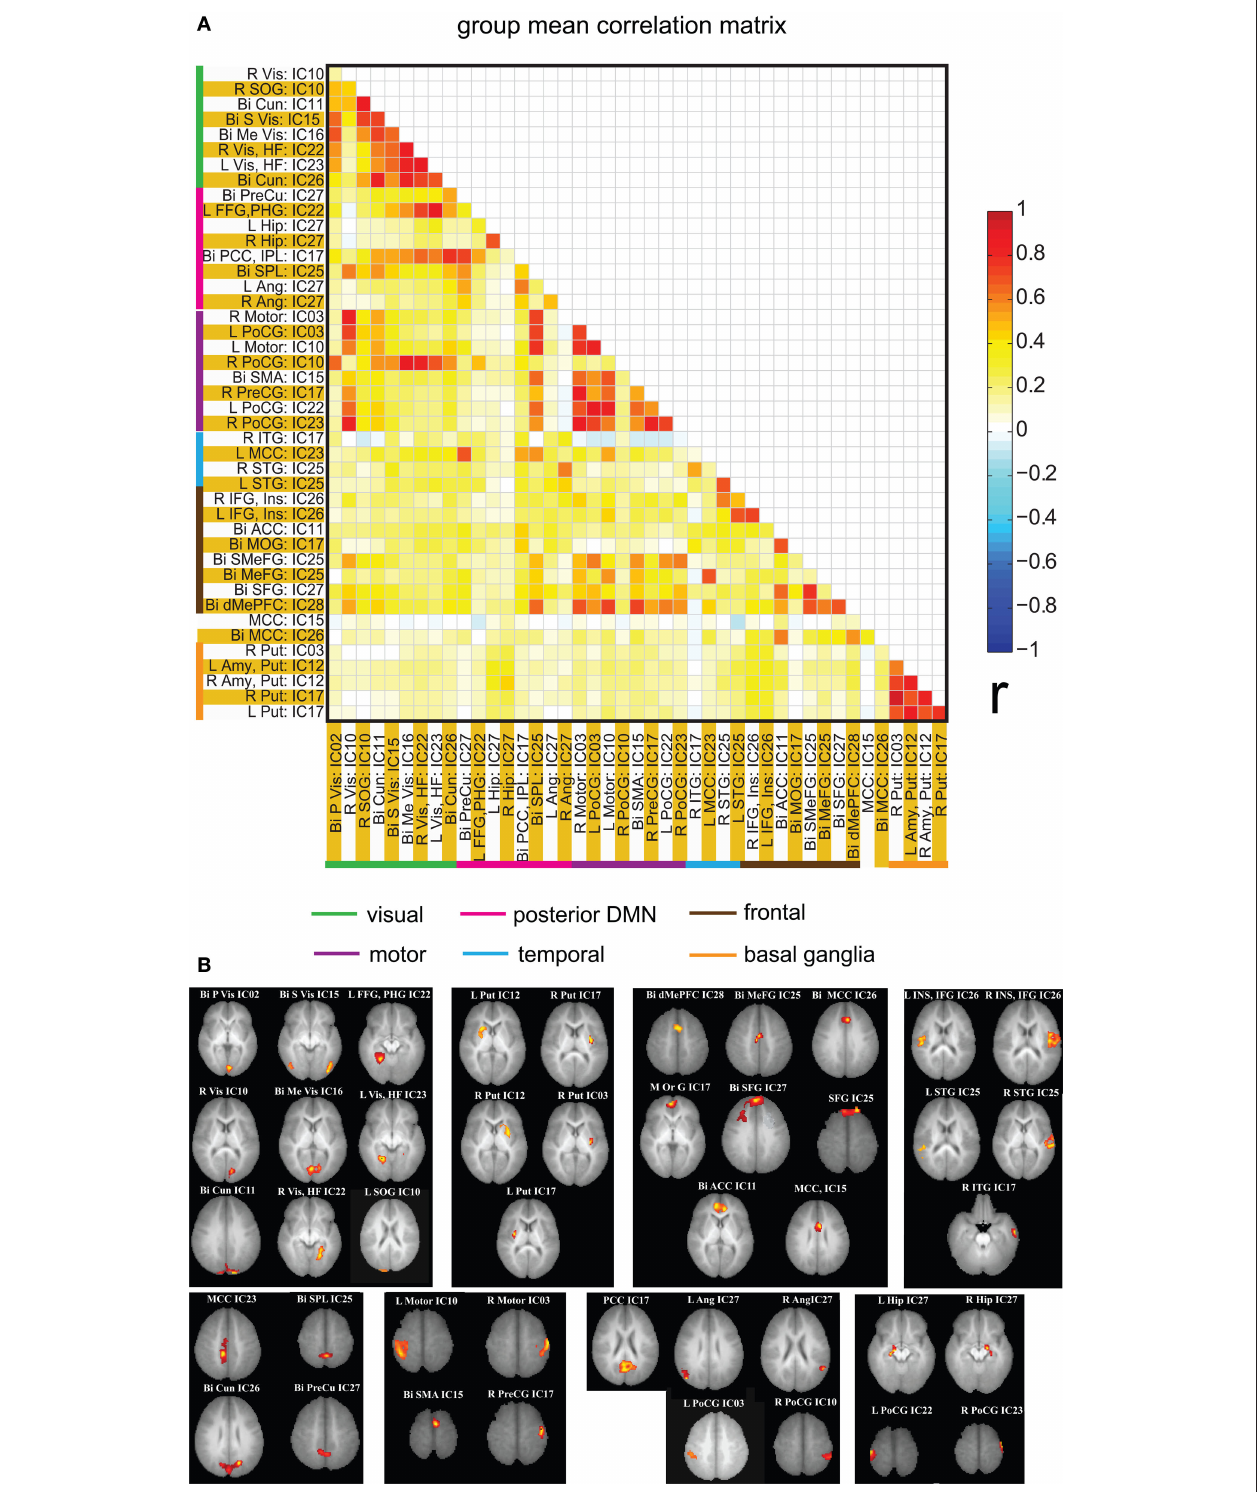
next to ROI labels shows the grouping of regions based on their location in brain. Abbreviations of labels are listed in Table 2 and the brain regions are displayed in (B) . (B) Brain maps depicting the weighted ROI masks used in ROI